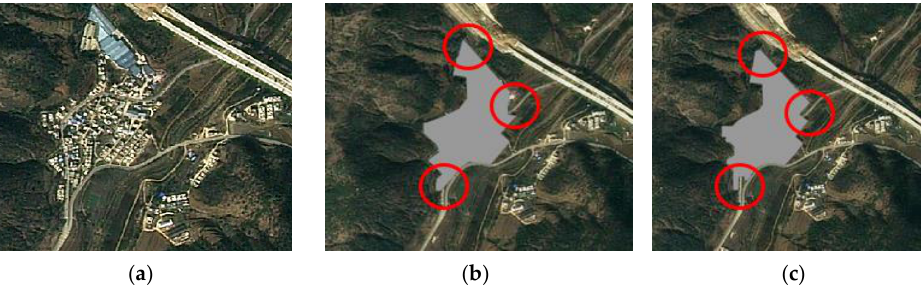
Figure 3. Comparison of traditional semantic segmentation labels and mapping application labels: ( a ) Original image; ( b ) semantic segmentation labels; and ( c ) mapping application